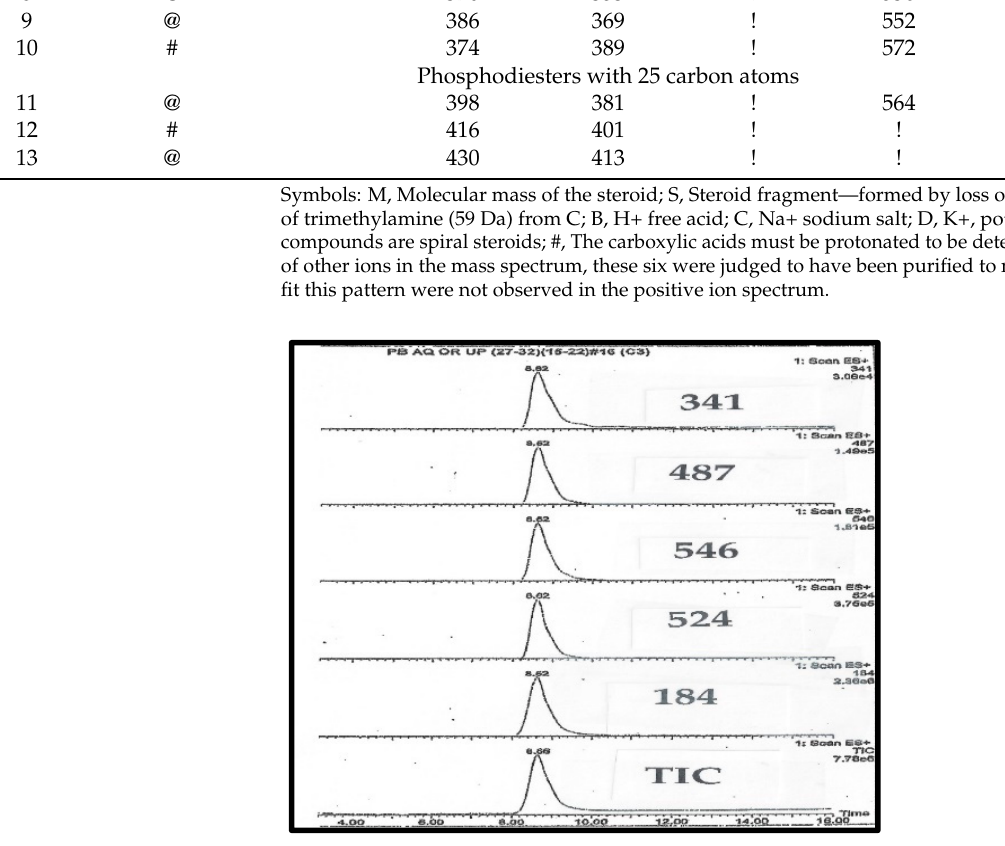
Figure 2. LC-MS chromatography of purified C341 isolated from pig Figure 2. LC ‐ MS chromatography of purified C341 isolated from pig blood.